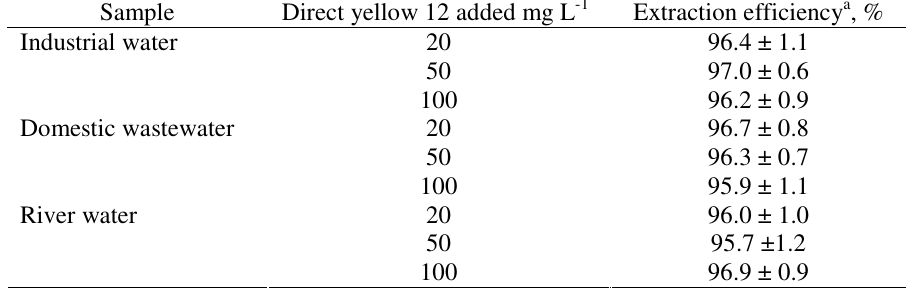
Table 3. Removal of direct yellow 12 in spiked water